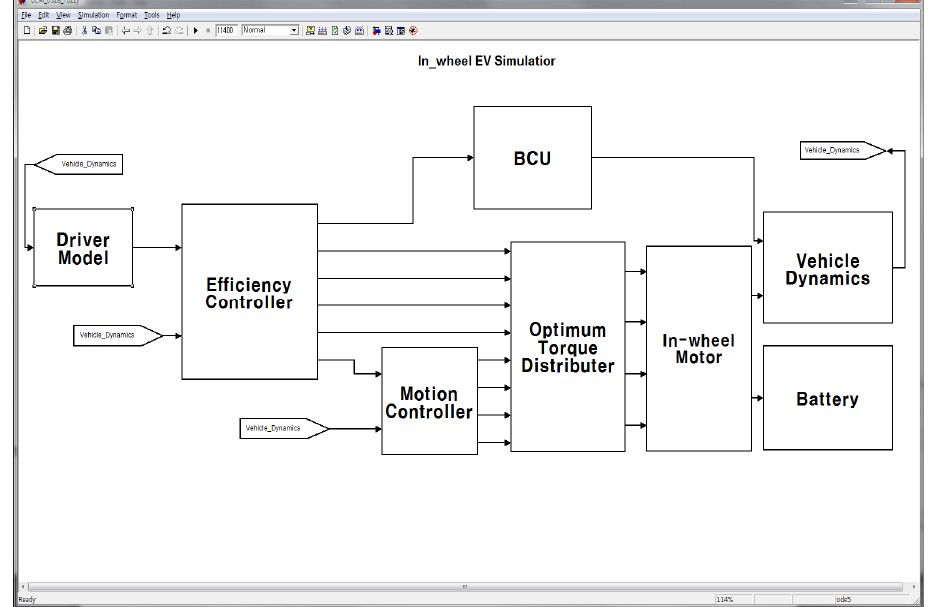
Figure 3. Powertrain model using